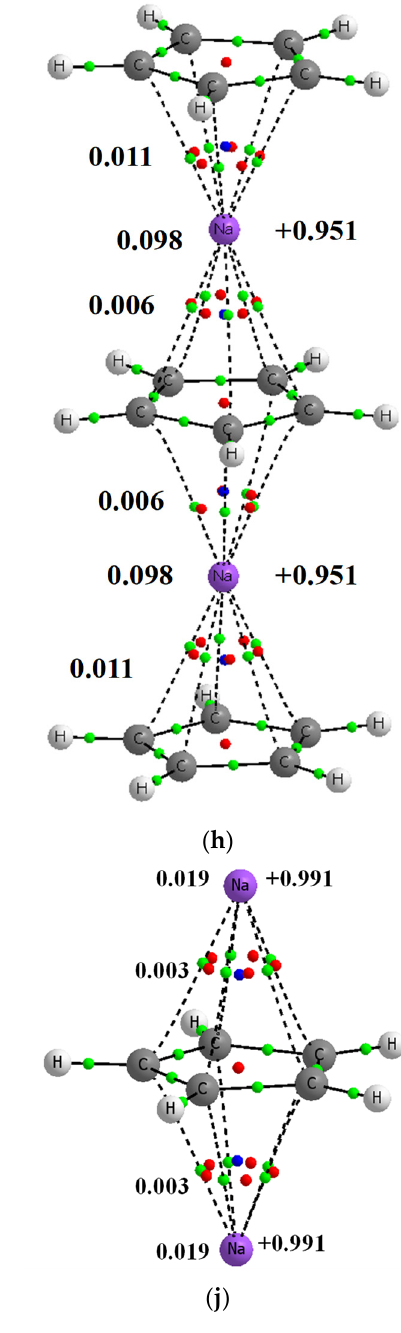
Figure 1. Molecular graphs of complexes’ analyzed here; big circles correspond to attractors and green small circles to bond critical points, while red and blue small circles correspond to ring and cage critical points, respectively. Continuous and broken lines indicate bond paths. Few characteristics of complexes are presented, NBO charges of lithium centers are presented at right sides of pictures, the Wiberg indices are given at the left side (of C ··· Li + /Na + contacts and of the whole Li + /Na + centers). ( a ) Li + C 5 H 5 − ( b ) Na + C 5 H 5 − ( c ) C 5 H 5 − Li + C 5 H 5 − ( d ) C 5 H 5 − Na + C 5 H 5 − ( e ) Li + C 5 H 5 − Li + C 5 H 5 − ( f ) Na + C 5 H 5 − Na + C 5 H 5 − ( g ) C 5 H 5 − Li + C 5 H 5 − Li + C 5 H 5 − ( h ) C 5 H 5 − Na + C 5 H 5 − Na + C 5 H 5 − ( i ) Li + C 5 H 5 − Li + ( j ) Na + C 5 H 5 − Na + .